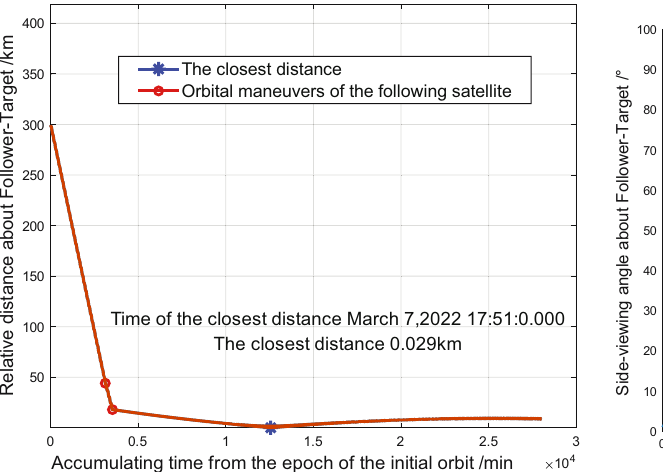
Figure 2: Variation in the relative distance of two satellites caused by the capture control method.